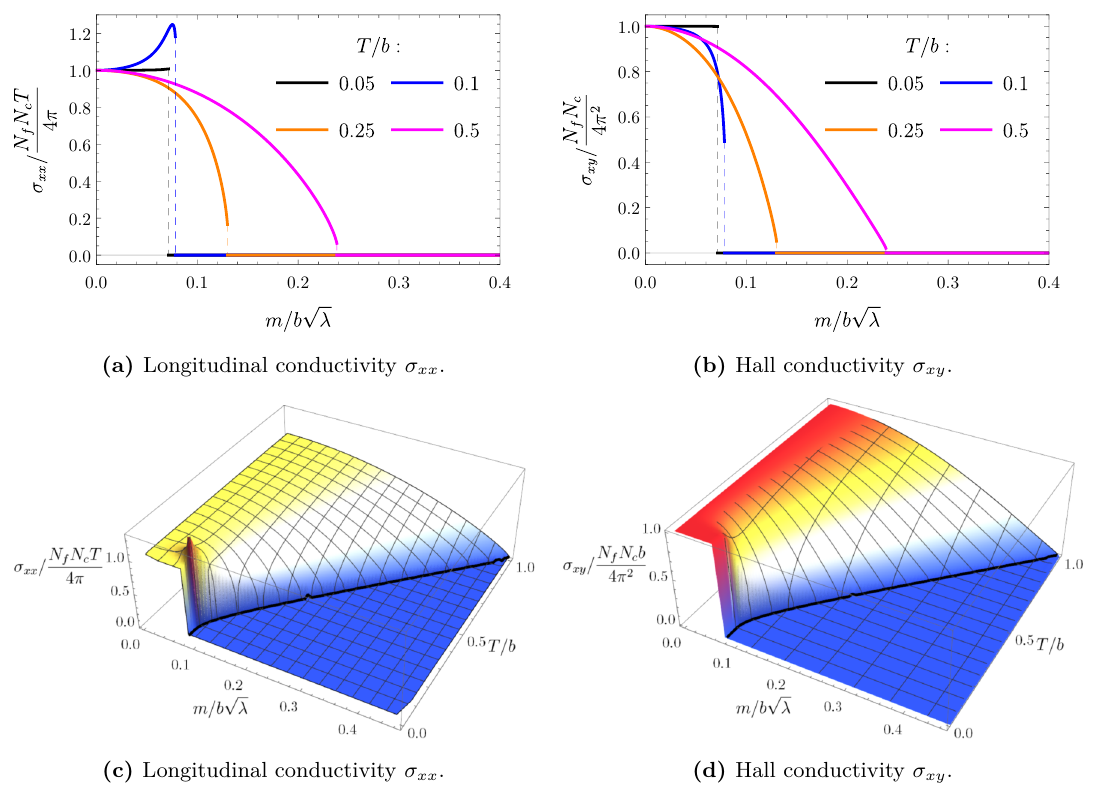
Figure 6. Our numerical results for (a) the DC longitudinal conductivity, σ xx / ( N f N c T/ 4 π ) , and √ (b) the DC Hall conductivity, σ xy / ( N f N c / (4 π 2 )) , as functions of m/ ( b λ ) , for T/b = 0 . 05 (black) 0 . 1 (blue), 0 . 25 (orange), and 0 . 5 (purple). In each case the vertical dashed line indicates the √ λ ) approaches the transition from below, σ xy first order phase transition of figure 4. As m/ ( b decreases monotonically for all T/b , reaching σ xy = 0 at the transition. In contrast, σ xx decreases monotonically for larger T/b , but exhibits a maximum near the transition at small T/b . For √ m/ ( b λ ) above the transition, σ xx = 0 and σ xy = 0 . (c) and (d) 3D plots of our numerical